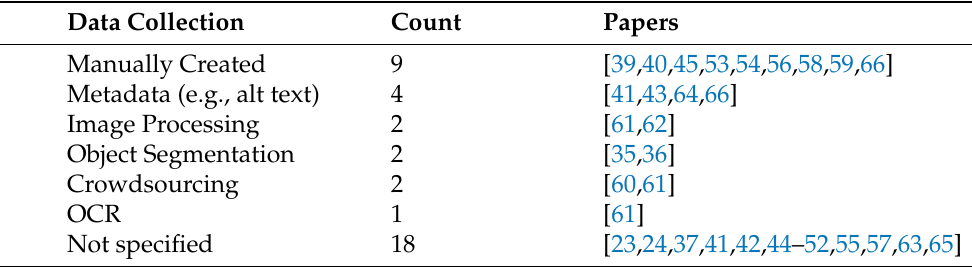
Table 3. Data preparation/collection methods for providing image-related information.